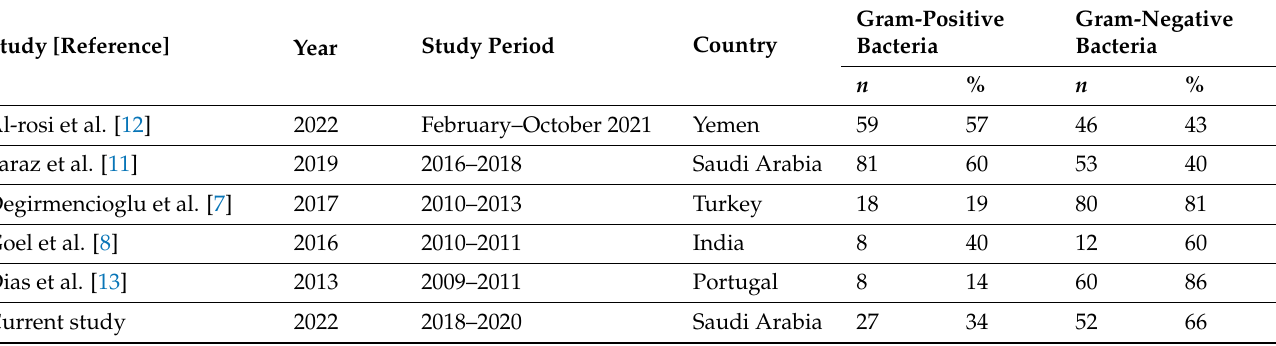
Table 4. Some reports from various regions in the last ten years with the prevalence of Gram-positive and Gram-negative bacterial HAC in